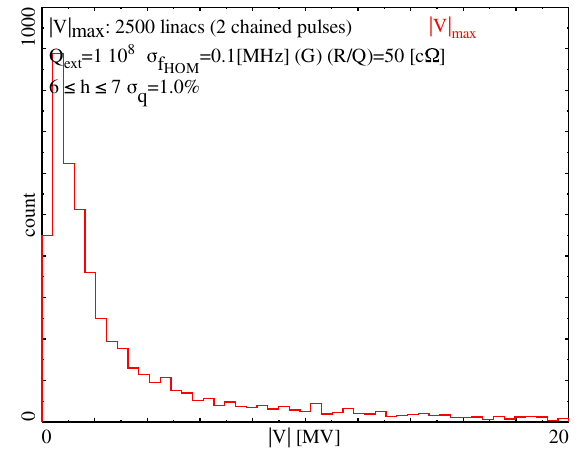
FIG. 20. (Color) Histogram of dt [0–50 ps, 50 bins] for Q ext ¼ 10 8 , worst: red; rms: blue; 2500 different HOM setups; con- ditions as in Fig. 8.